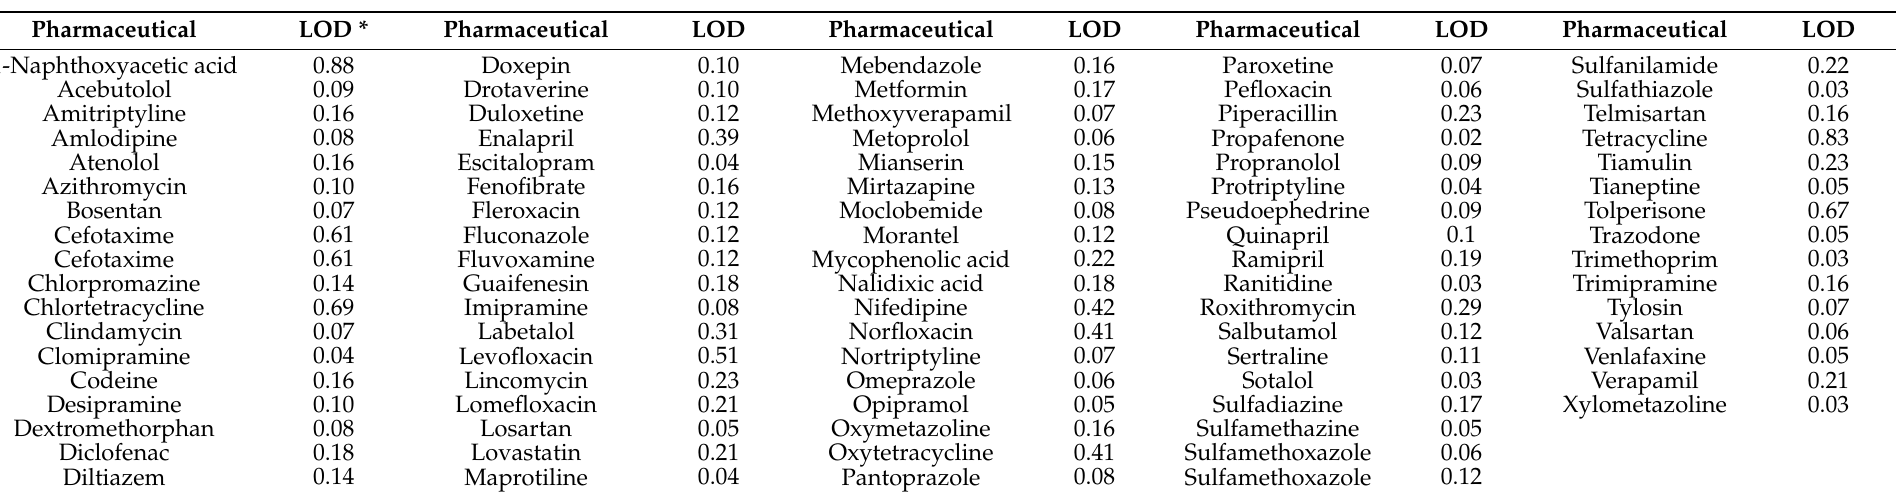
Table 2. Pharmaceuticals and selected metabolites which were not detected in fish muscle with their limit of detection